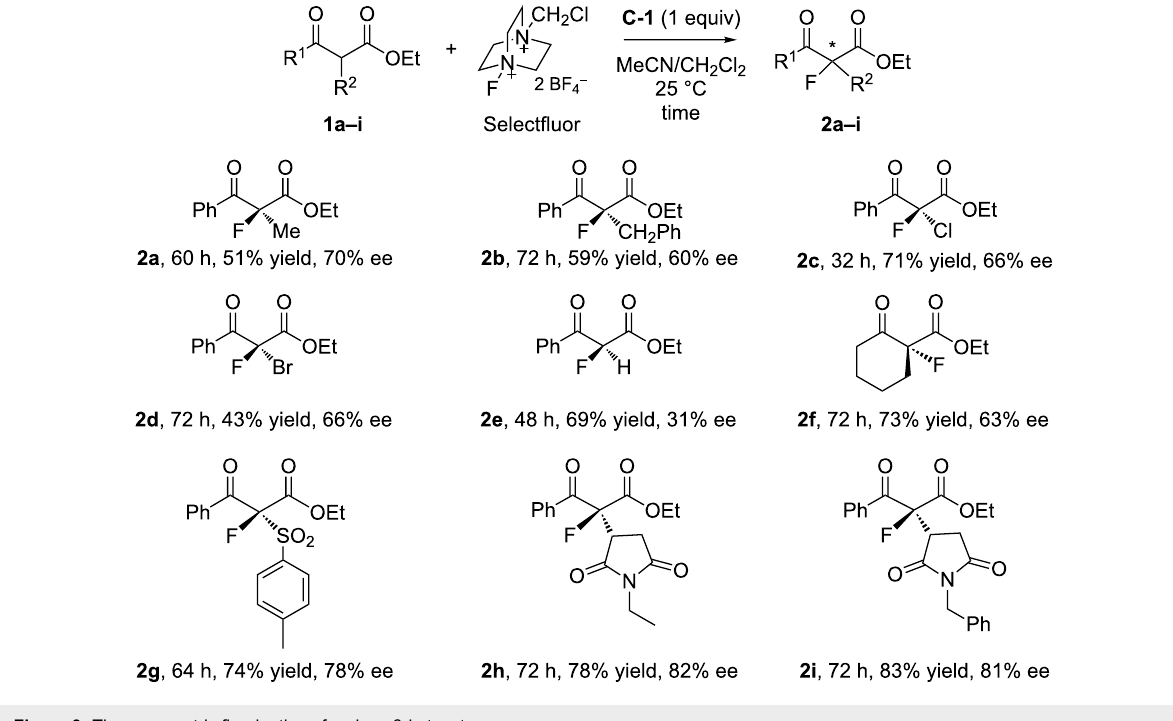
Figure 3: The asymmetric fluorination of various β -ketoesters.